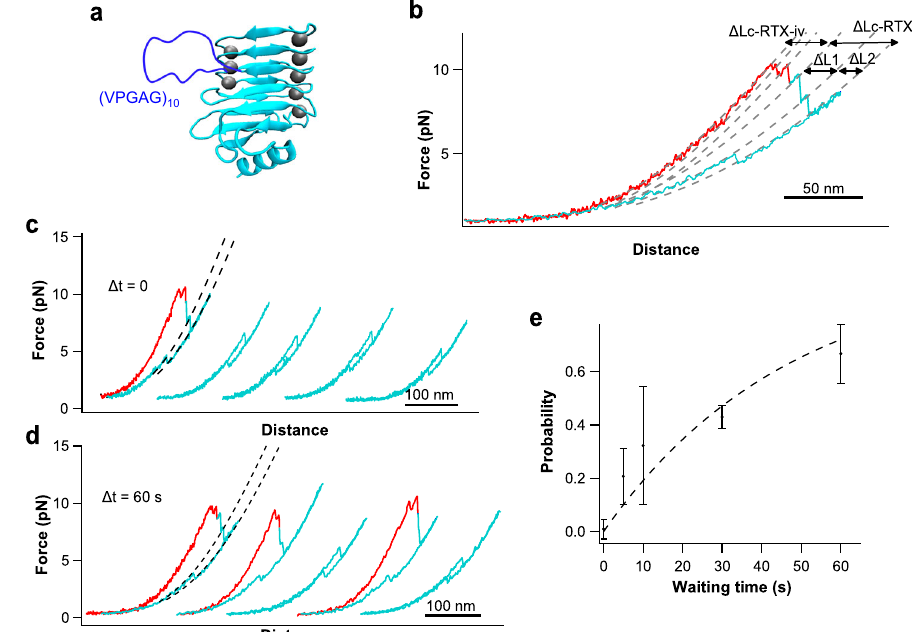
Fig. 5 The folding of RTX-iv is conditional upon the folding of the whole RTX-v. a Schematics of the structure of RTX-v 50 . RTX-v 50 is constructed by inserting an intrinsically disordered elastin-like sequence (VPGAG) 10 between residue Leu1572 and Ser1573 in wt RTX-v. b A representative stretching – relaxation F – D curve of RTX-iv-v 50 . The unfolding event of RTX-iv is colored in red, and the unfolding and partial refolding events of RTX-v 50 are colored in cyan. c , d Consecutive F – D curves showing the unfolding and refolding of RTX-iv-v 50 . The unfolding event of RTX-iv is colored in red, and unfolding and refolding events of RTX-v 50 are colored in cyan. c No waiting time ( Δ t ) was allowed between consecutive stretching – relaxation cycles, while in ( d ) Δ t was 60 s. In the relaxation curves of RTX-iv-v 50 , only the refolding of C-FI at ∼ 4 pN was observed, while no trajectory in which both RTX-iv and the N-terminal part of RTX-v refolded was observed. e The relationship of folding probability versus Δ t at zero force of the N-terminal part of RTX-v 50 . Fitting the data to the fi rst-order kinetics led to a folding rate constant of (2.1 ± 0.4) × 10 − 2 s − 1 of the N-terminal part of RTX-v 50 at zero force. The number of events at Δ t = 0, 5, 10, 30, 60 s are 172, 47, 35, 57, and 24, respectively. The error bars indicate standard